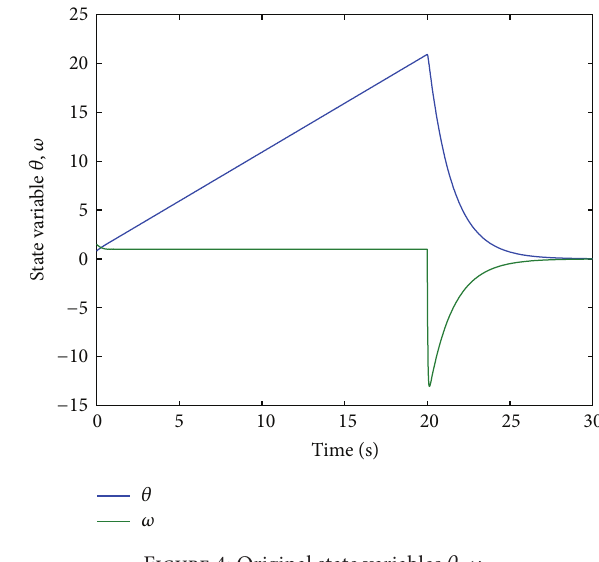
Figure 2: State variables 𝑥 1 , 𝑥 4 .